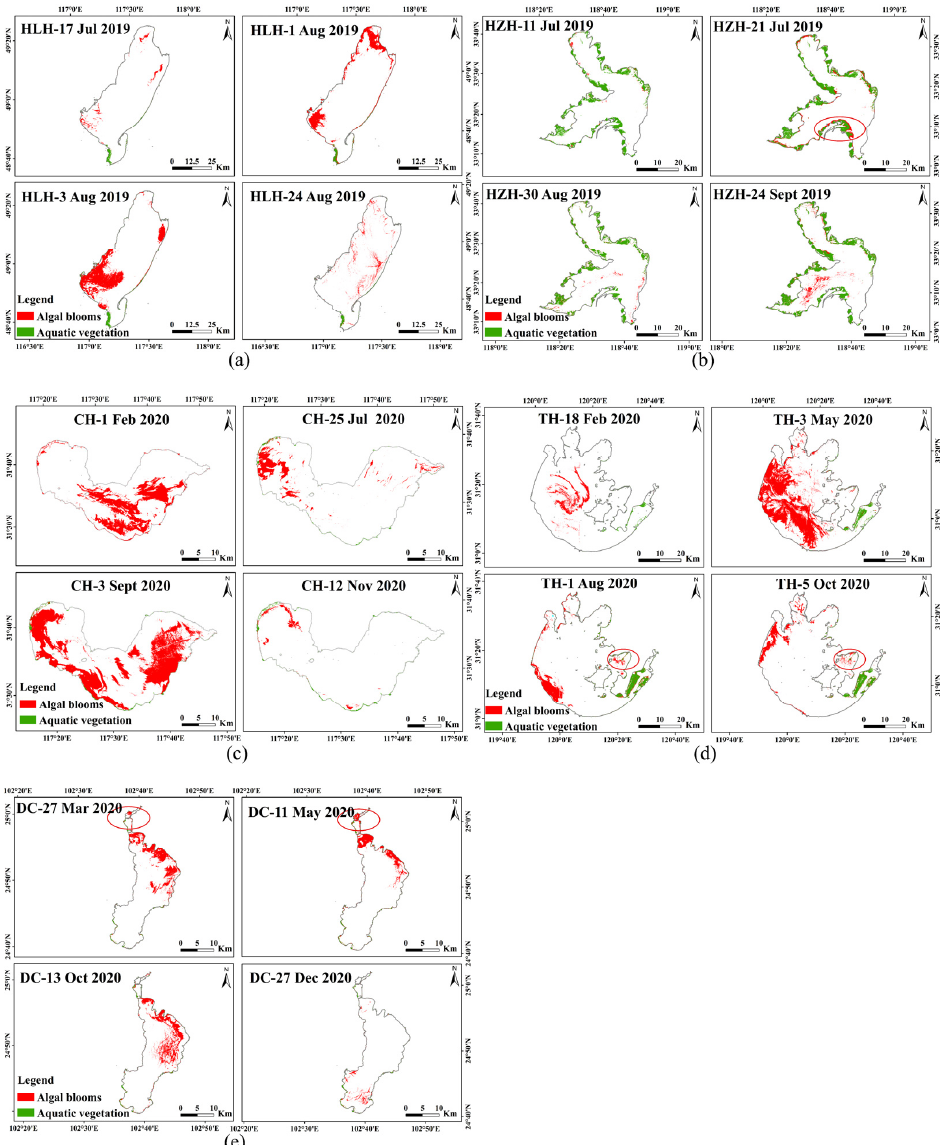
Figure 5. This figure shows the results of the identification of algal blooms and aquatic vegetation in the studied lakes on selected dates of algal outbreaks, using the modified VPF method. The red areas represent algal blooms, and the green areas represent aquatic vegetation; ( a – e ) are the identification results of Lake Hulun, Hongze, Chaohu, Taihu, and Dianchi, respectively. In the image, HLH means Lake Hulun, HZH means Lake Hongze, CH means Lake Chaohu, TH means Lake Taihu, and DC means Lake Dianchi. HLH-17 July 2019 means the image identification result of Lake Hulun on 17 July 2019. The numbers and letters following the abbreviations of the other lakes are the dates of the images.